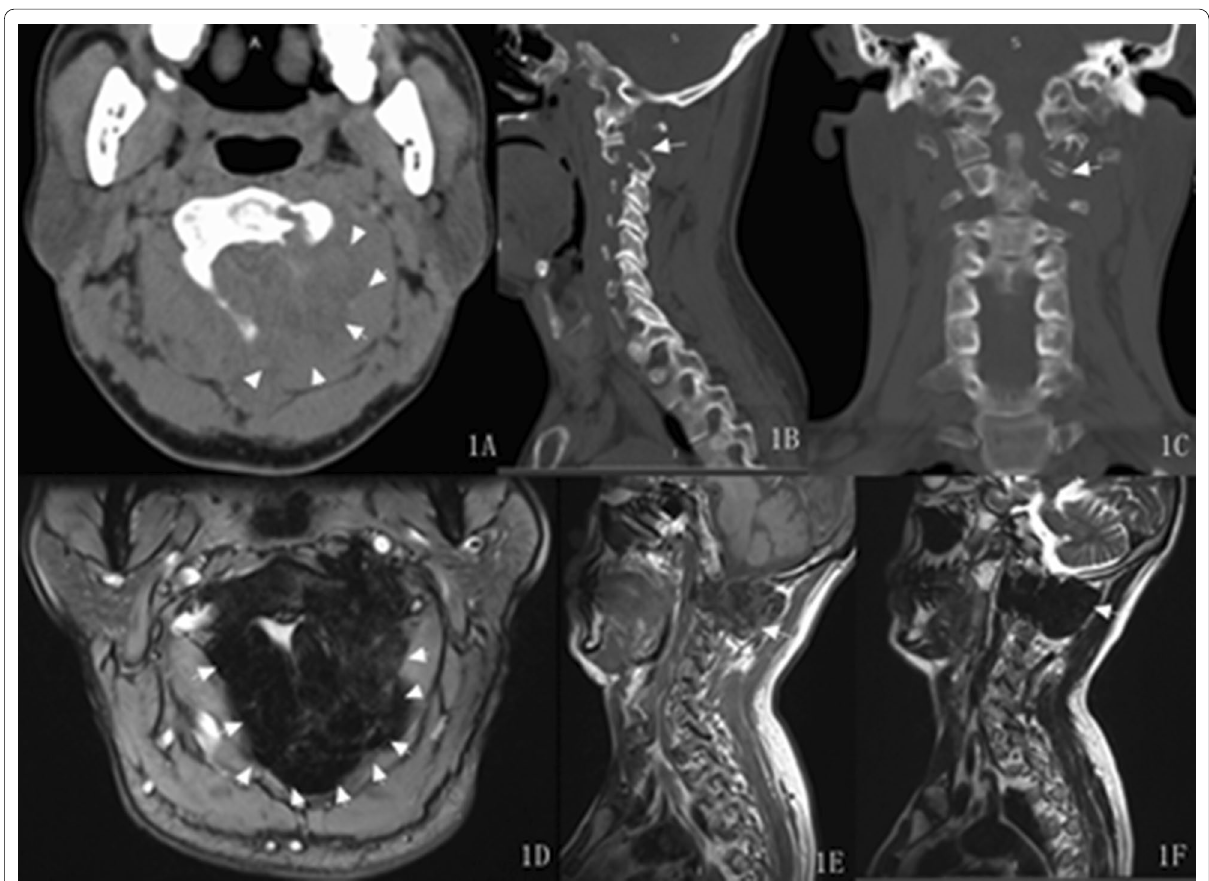
Fig. 1 A 49-year-old male with benign GCTTS. The lesion, centred on the facet joint of the C1-2 vertebra, was expansive and osteolytic bone destruction with cortical discontinuity ( A – C , arrow). The tumour appeared mainly hypointense on T1WI ( E , arrow) and hypointense on T2WI ( D , F ,